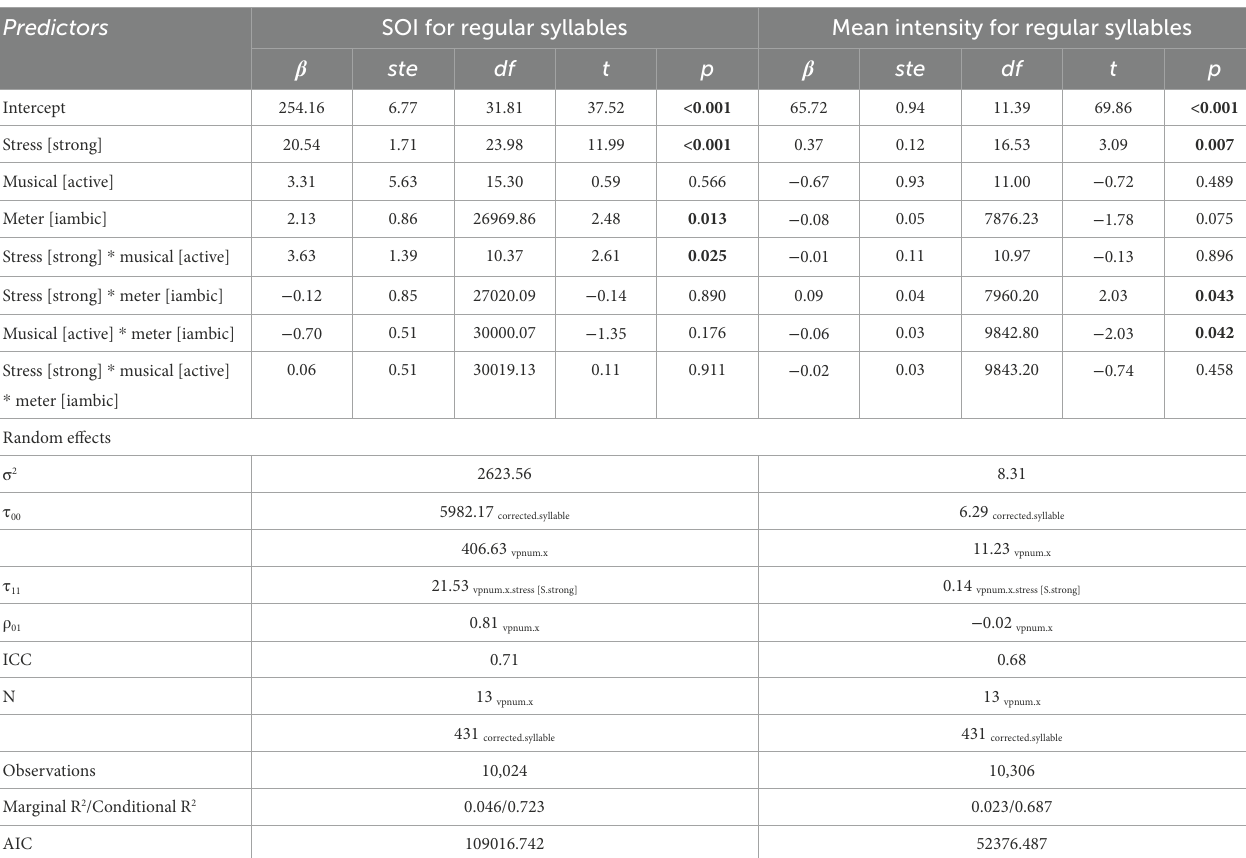
TABLE 1 Syllable onset intervals and mean intensity for regular syllables.